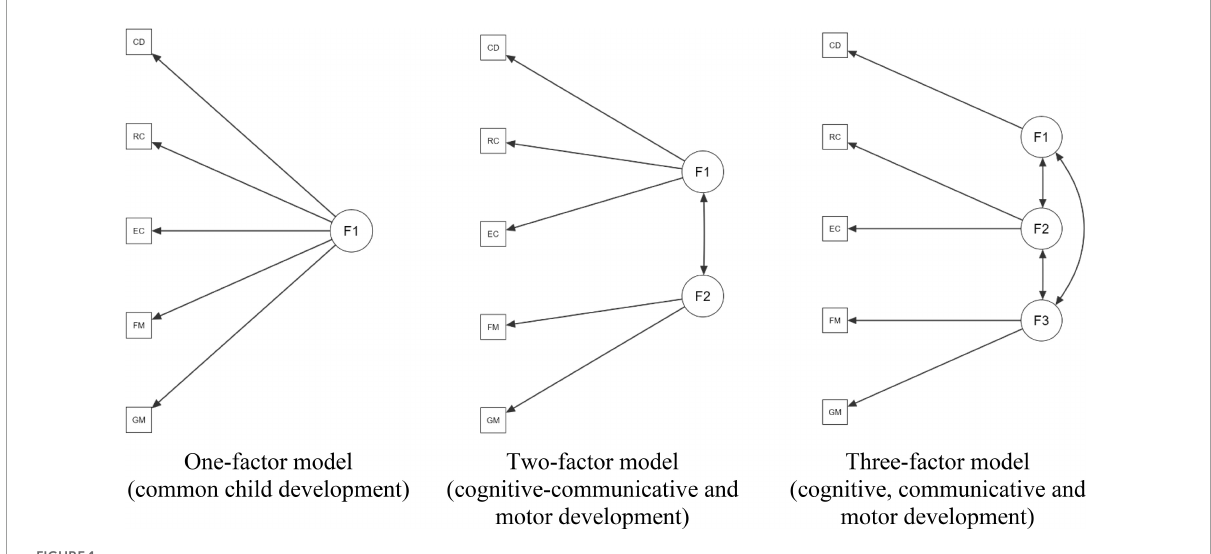
FIGURE1 Theoretical models of Bayley-III factor structure. CD, cognitive development; RC, receptive communication; EC, expressive communication; FM, fine motor; GM, gross motor.